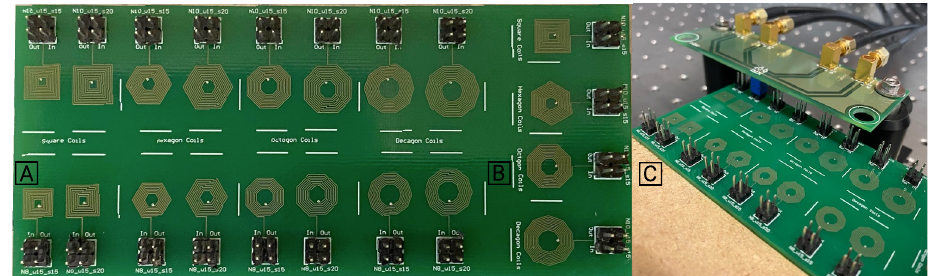
Figure 14. The PCB produced has coils with 4, 6, 8, and 10 segments per turn, all with an inner segment of 1.3 mm. In A: are represented the one-layer coils, in the top line are coils with ten turns and in the bottom line coils with eight turns; in B: are the two-layer coils, with ten turns; and in C: the measurement setup.